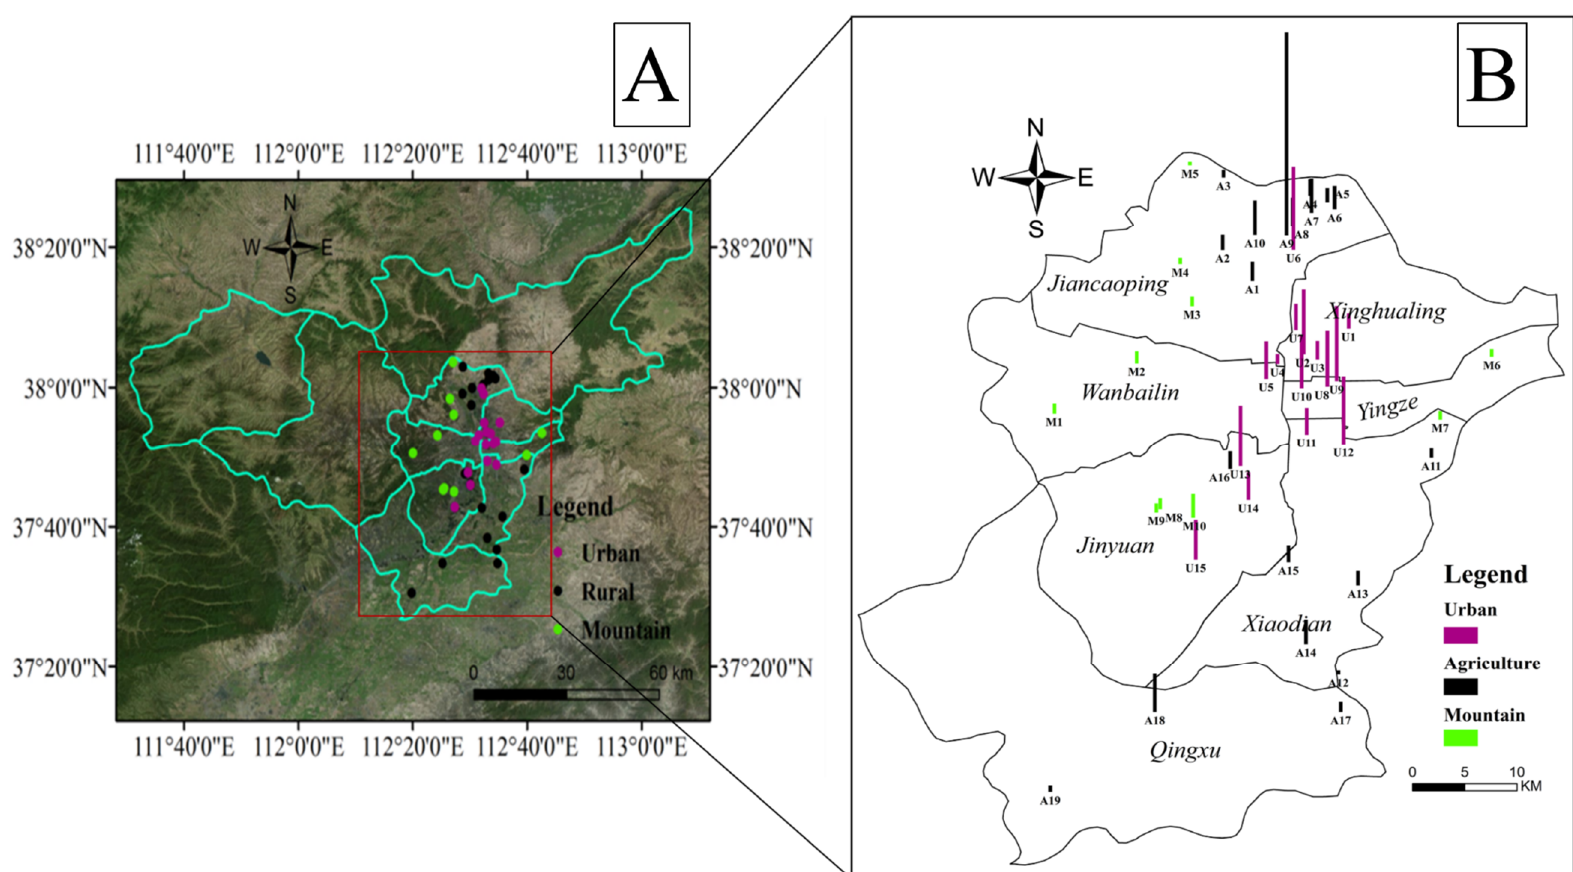
(cid:80) 16PAHs in each